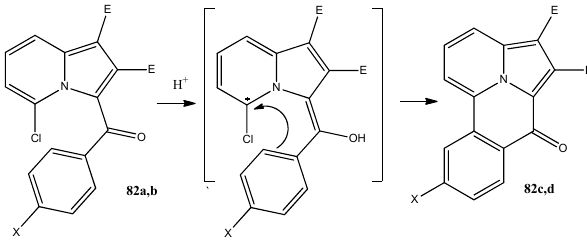
Table 21. Substituents and yields of the ring closure reaction on Scheme 45. We found that 5-chloro-3-benzoyl indolizines 82a , b in acidic conditions closed the ring [102,103], Scheme 46, forming benzocyclazine derivatives 82c , d (X = Cl 83%, X = NO 2 90%). Here the protonation opened direct link to 1,10-polyene which under- went ring closure.